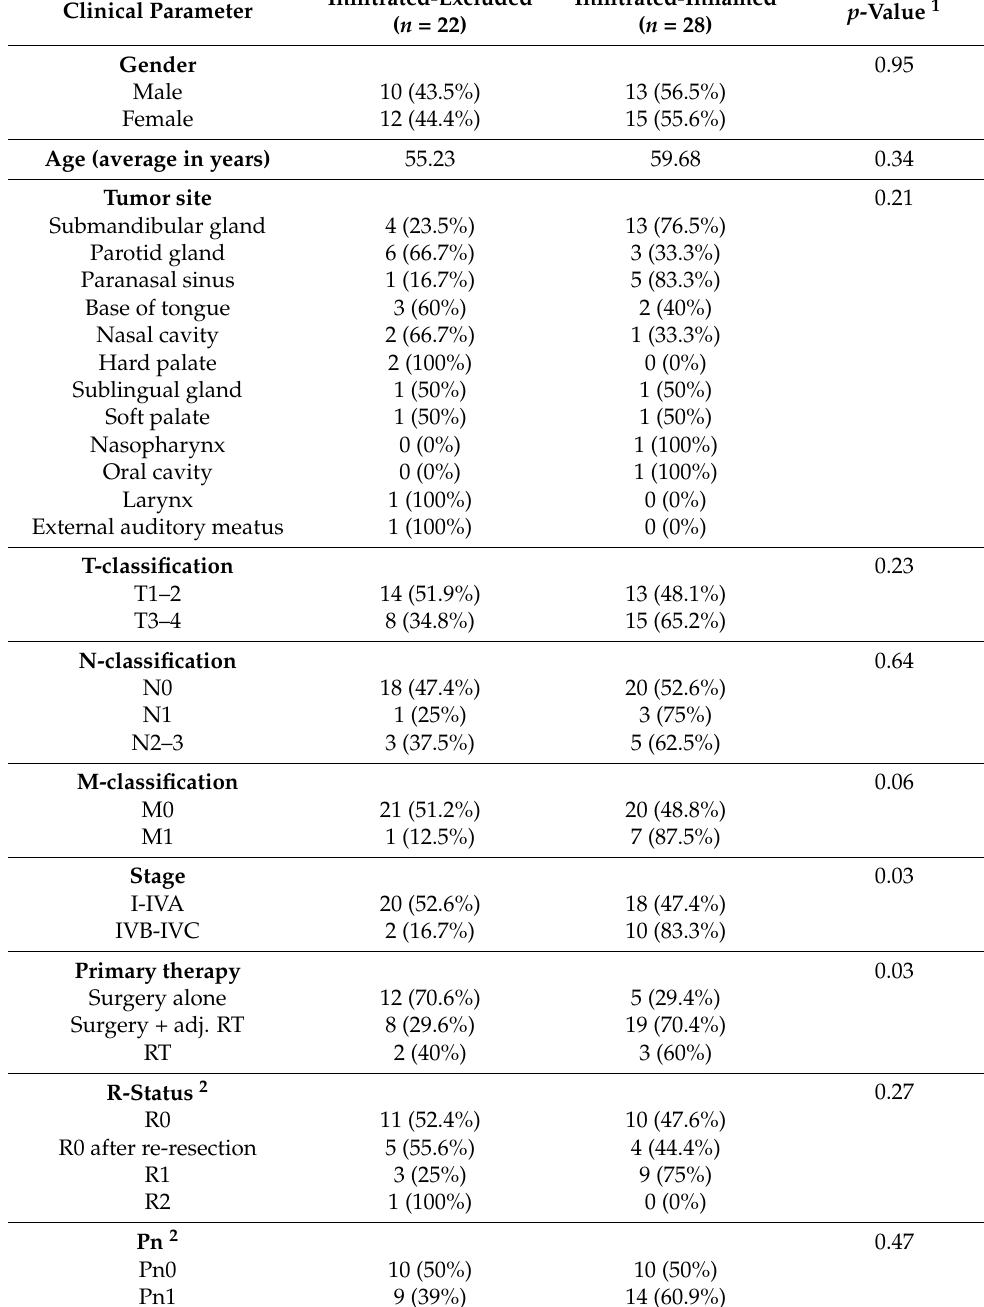
Table 1. Patient characteristics at initial diagnosis and treatment parameters stratified by TIL